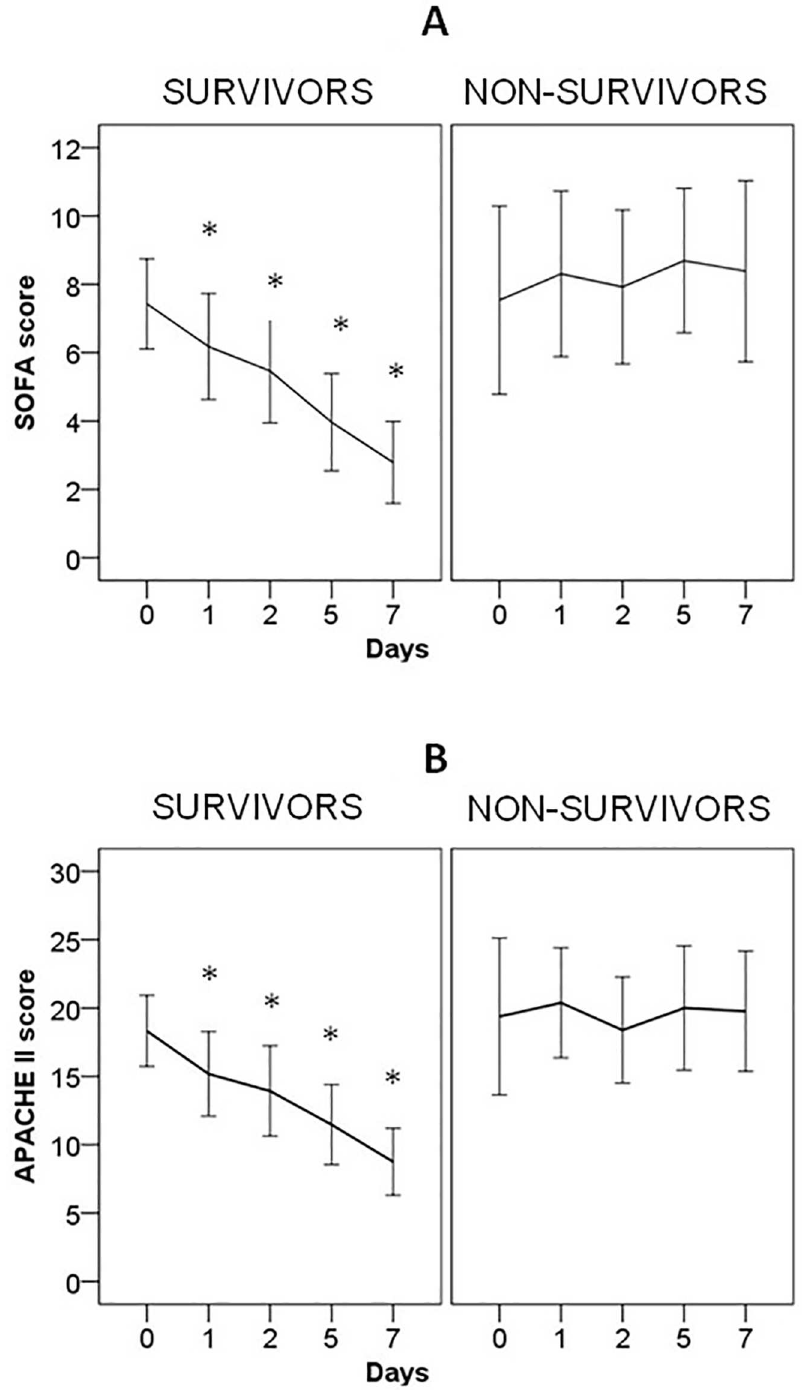
Fig 1. Changesof SOFA (A) and APACHE II (B) scores of patients with severe sepsis/septic shock during the first 7 days of ICU stay. Patients are classifiedin two groups: survivors and non-survivors. Data are shown as mean (95% confidenceinterval). Survivors shown significantdecreases of SOFA and APACHE II scores from day 0 to the followeddays ( * , p < 0,001). In contrast, no significantdifference of SOFA and APACHE II scores was detected in non-survivors patients in the days of ICU